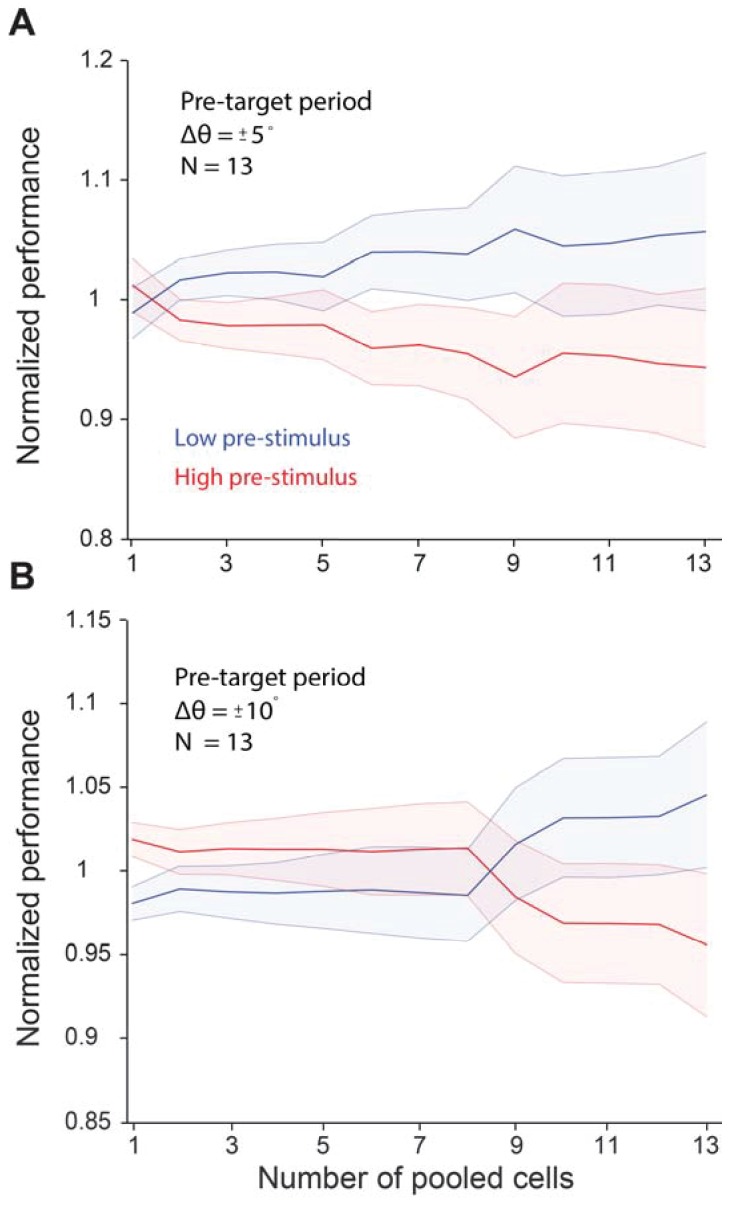
Pre-target neural activity does not influence behavioral performance in a significant manner.Behavioral performance was higher in the low pre-target response state when the relative difference between the target and test (Δθ) was ± 5° (p=0.40, Wilcoxon rank-sum at highest population level). We did not find a significant difference when Δθ was ± 10° (p=0.09, Wilcoxon rank-sum at highest population level). The five degree orientation data includes data from monkeys 1 and 2. The 10 deg data includes data from monkeys 1, 2, and 4. Error bars represent s.e.m.